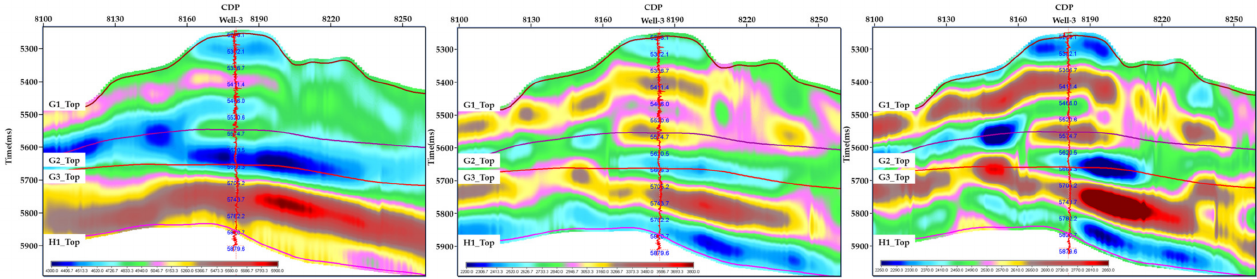
Figure 6. Low-frequency models for prestack multiparameter joint inversion. From left to right are the initial inversion models based on P-wave velocity, S-wave velocity and density, respectively.